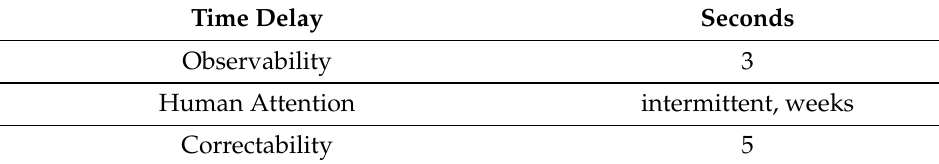
Table 9. Time delay, human attention, and correctability for Roomba.